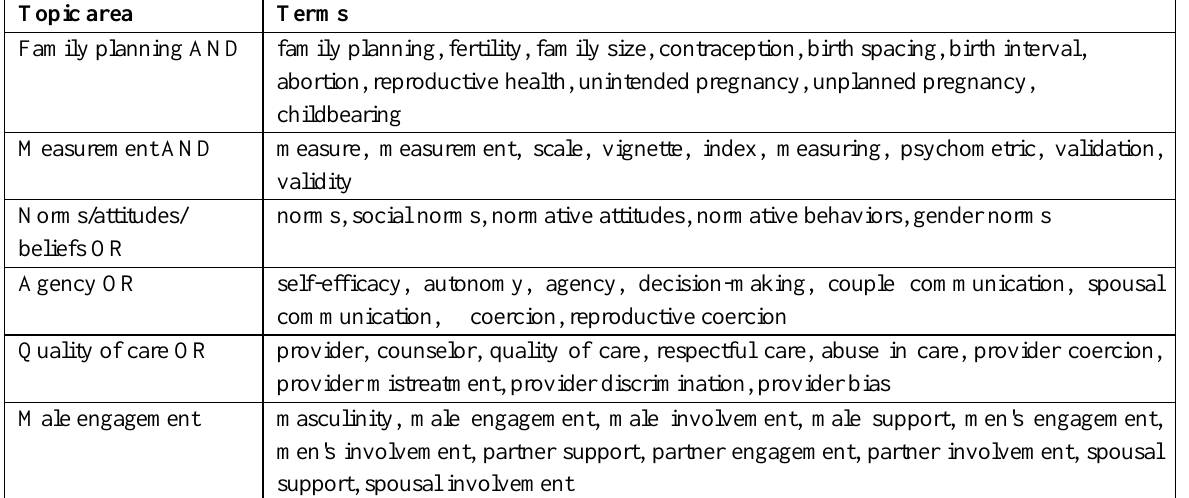
Table 2: Search terms used for conducting the review of literature Topic